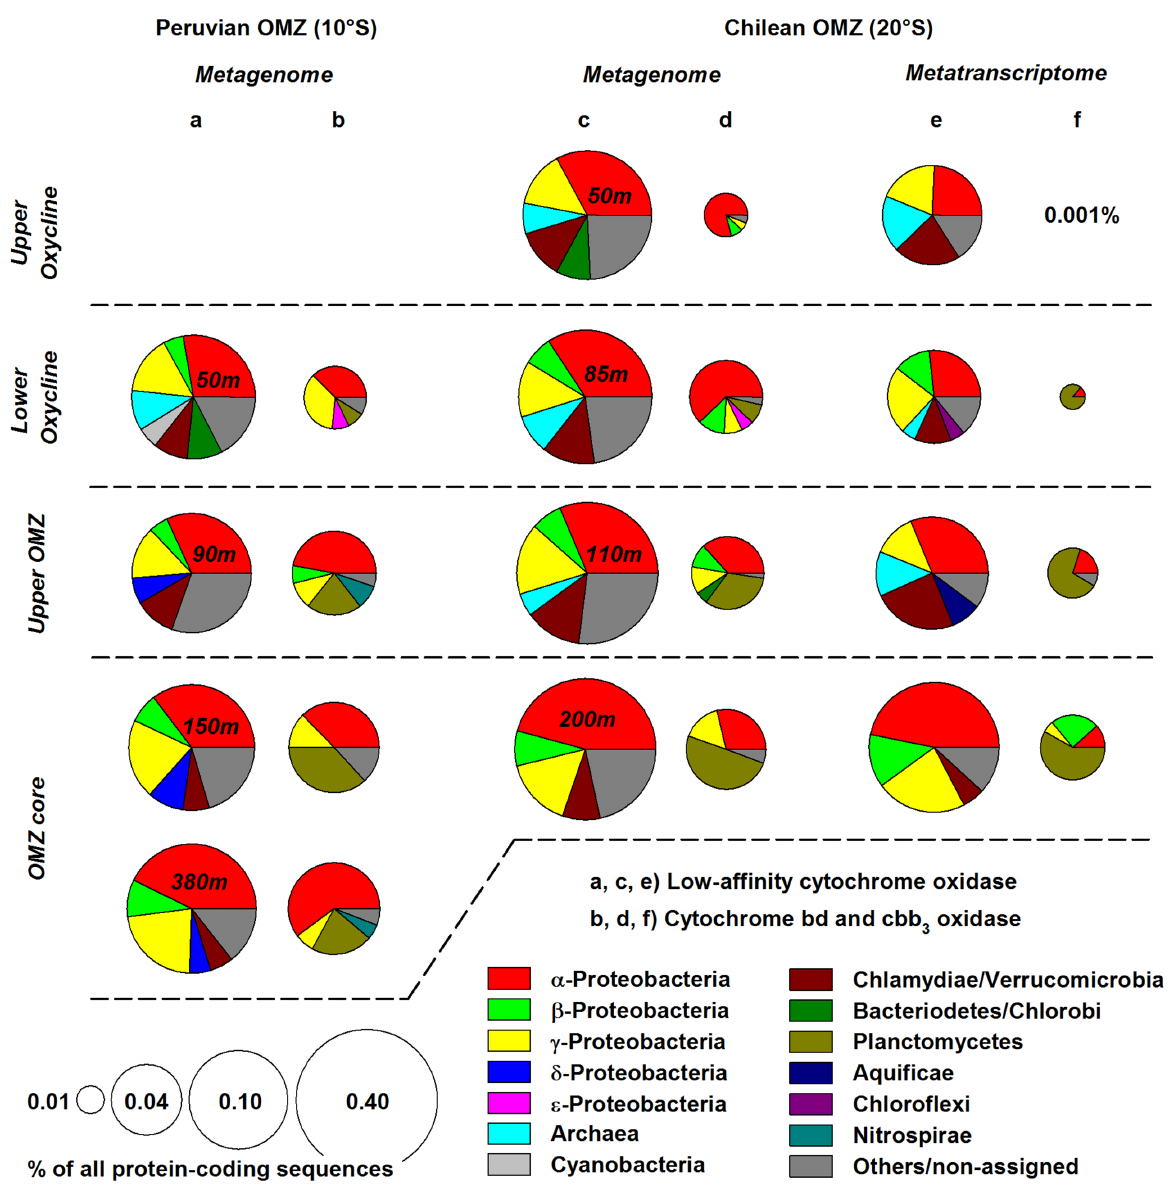
Fig 2. Abundance of genes and transcripts encoding for terminal respiratory oxidases in the ETSP OMZ. (a, b) Abundance of low-affinity (cytochrome c oxidase) and high-affinity (cytochrome bd and cbb 3 oxidase) aerobic oxidases in the Peruvian OMZ (station 3). (c-f) Abundance and expression of cytochrome oxidase genes in the OMZ off Chile during cruise MOOMZ-1 [34]. Taxonomic affiliations of cytochrome oxidases are shown on domain, phylum or class level if represented by at least 5% of oxidase-coding sequences. Exact abundance and expression levels as well as taxonomic assignments of the individual types of cytochrome oxidases are given in S3